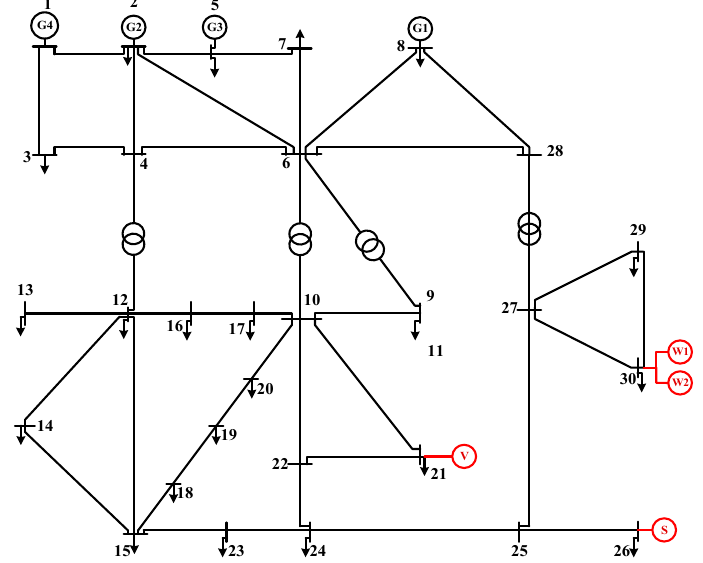
Figure 3. IEEE-30 bus network model with DGs and EVs. Table 1. Cumulant of DGs and EVs.